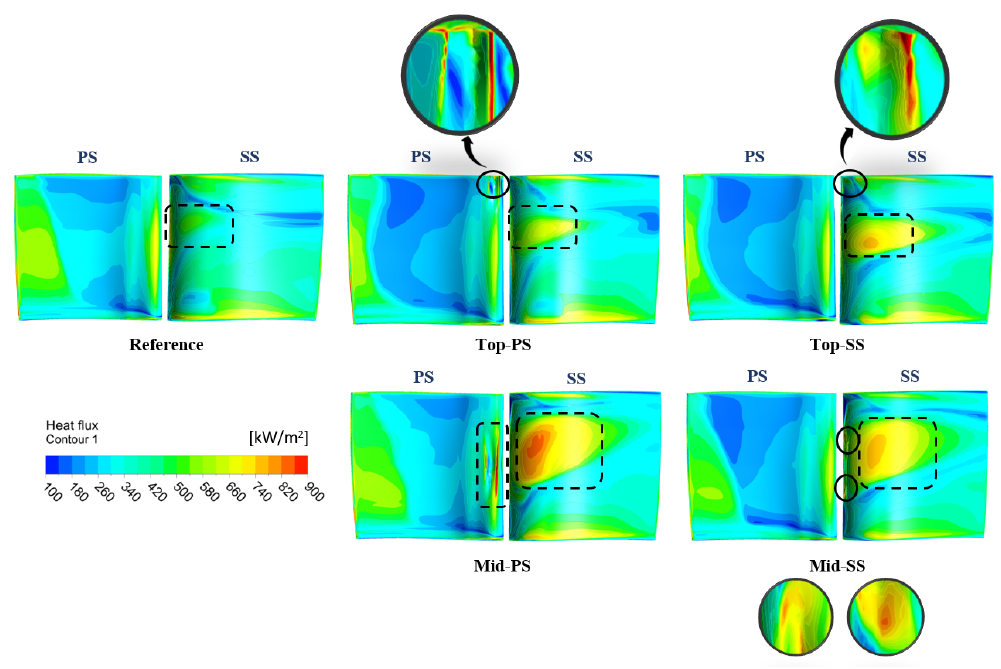
Figure 15. Heat flux distribution on the R 1 blade under various blade conditions.